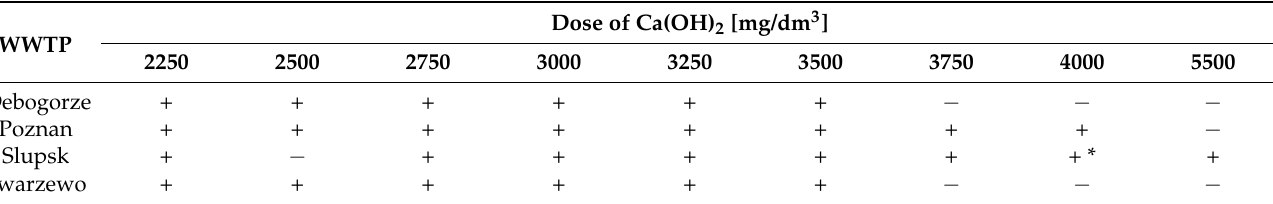
Figure 1. Measuring the effectiveness of phosphorus precipitation in laboratory model—overview diagram. Table 2. Doses of Ca(OH) 2 used in the